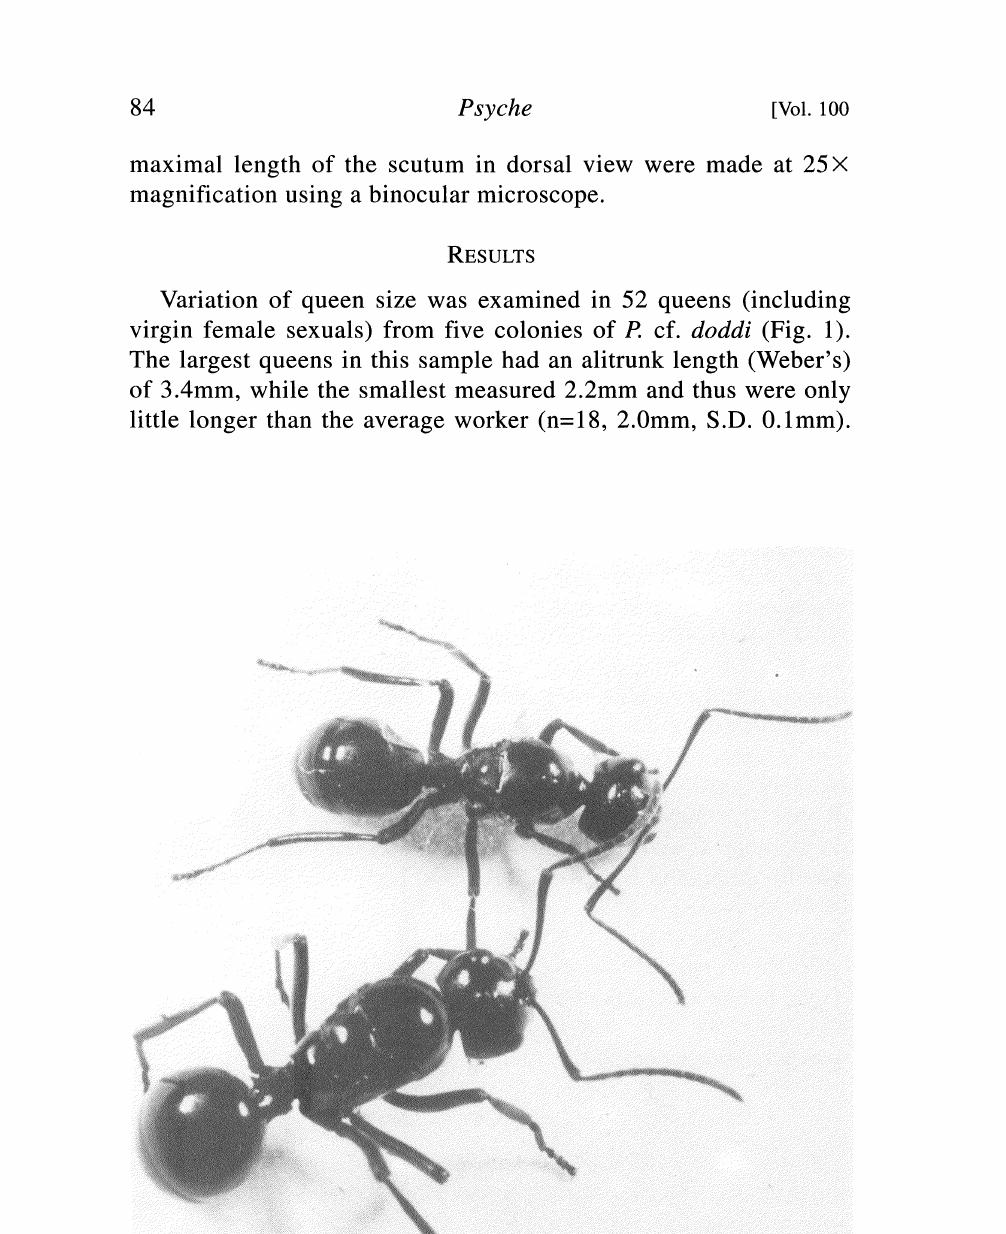
Fig. 1. A large and a small queen of the Australian weaver ant, Polyrhachis cf.